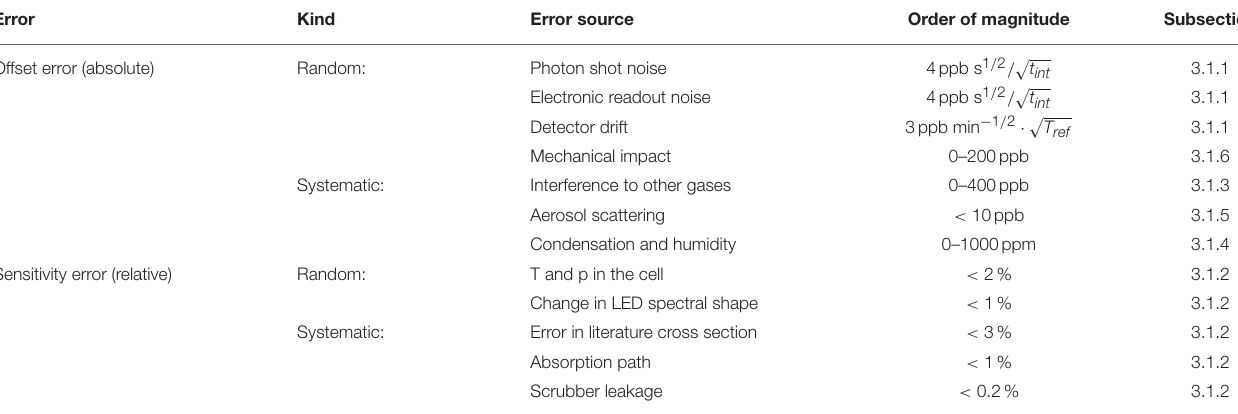
TABLE 1 | Overview on the measurement error sources and their approximative impact on the detected SO 2 VMR. Error Kind Error source Order of magnitude Subsection